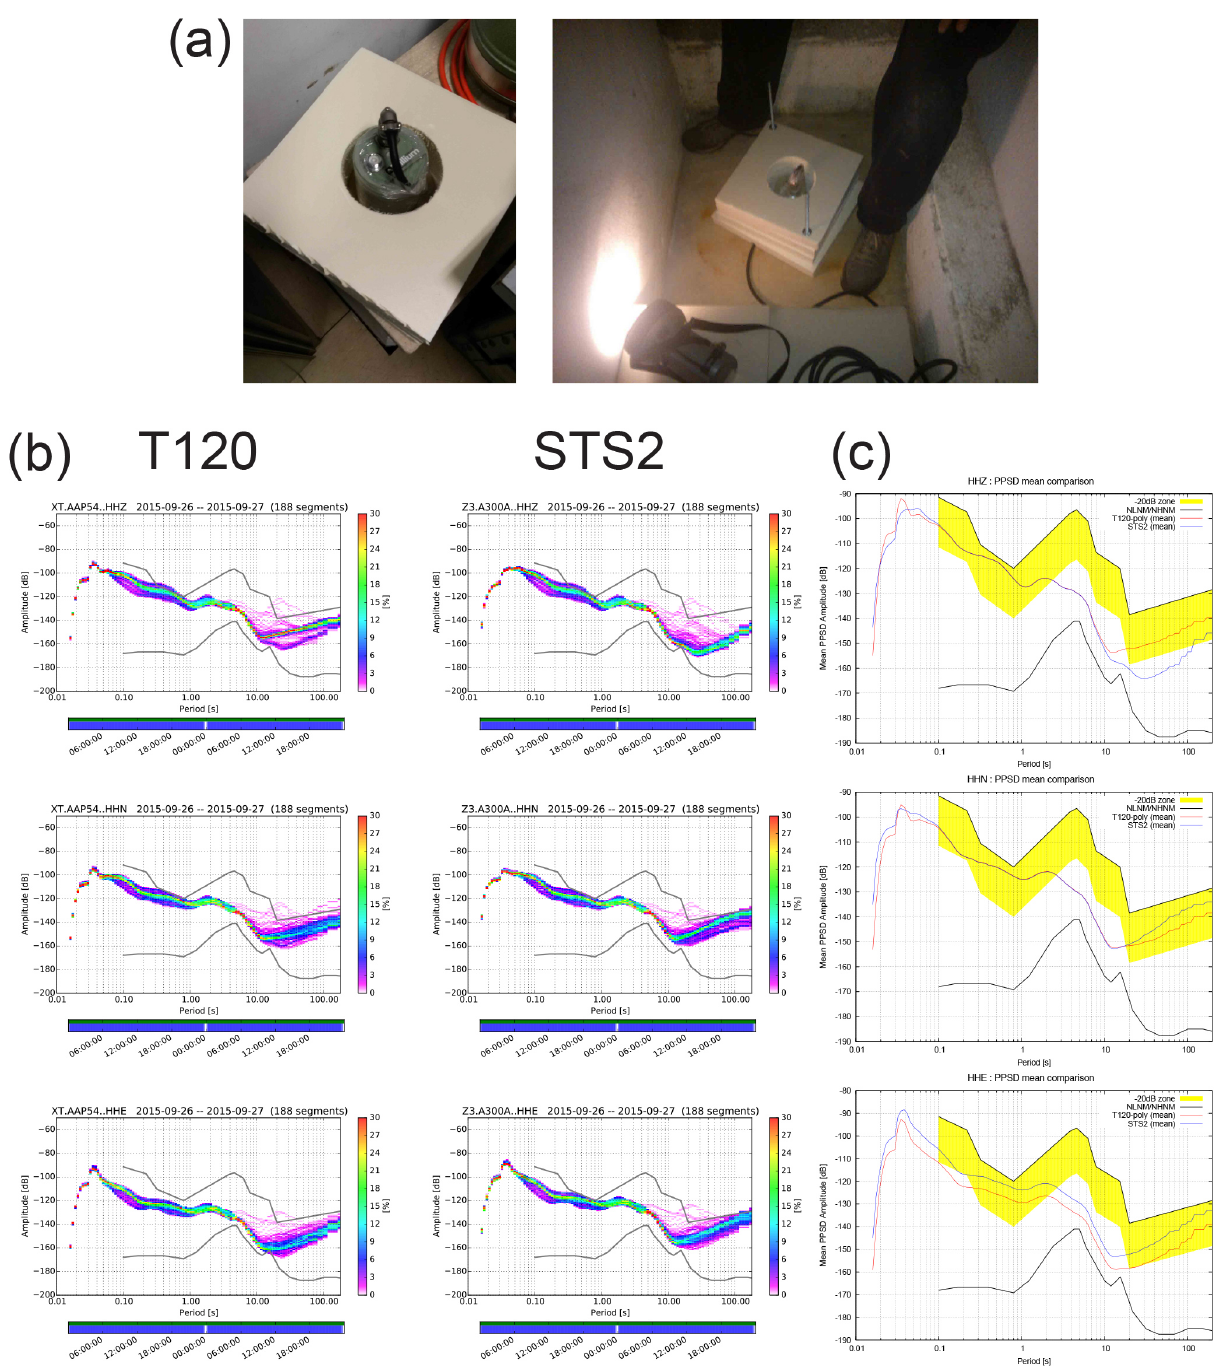
Figure 3. A custom made thermal insulation box for the Nanometrics Trillium Compact. The sensor is small and lightweight but these features are prone to signal pollution due to the strain of the cable and the high thermal capacity of the aluminium case. (a) the initial assembly of the 300 × 300mm polystyrene tiles with a central 128mm hole. The sensor is wrapped using a packaging film so that the sensor cable is kept firmly to the body of the sensor and reaches the ground with a glazing angle. (b) PPSD plots computed on 48h of continuous recording at 100sps with the ObsPy library. On the left the Trillium 120c and on the right the Streckeisen STS2 (the station codes used are fictitious). (c) The means of the PPSD shown in (b) are compared for each component with the New Low/High Noise model, the yellow band is the − 20dB from NHNM zone. With the insulation box the Trillium Compact has a noise comparable to the STS2 except for the vertical component that shows a bimodal